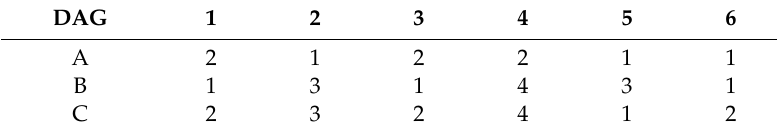
Table 3. Data length ( D ki ) of DAGs.